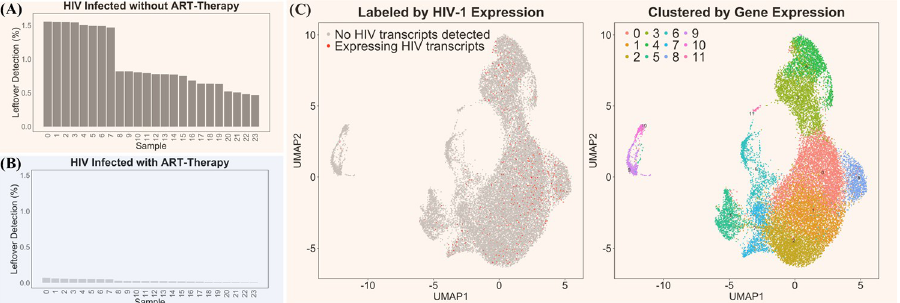
Fig 4. Venus’s single-cell analysis of HIV infection. (A) Percentage of unmappable human reads that mapped to HIV in HIV-infected (treatment one) (B) Percentage of unmappable human reads that mapped to HIV in HIV-infected, ART-treated (treatment two) (C) UMAP Left: labeled by HIV expression; Right: clustered by gene expression.